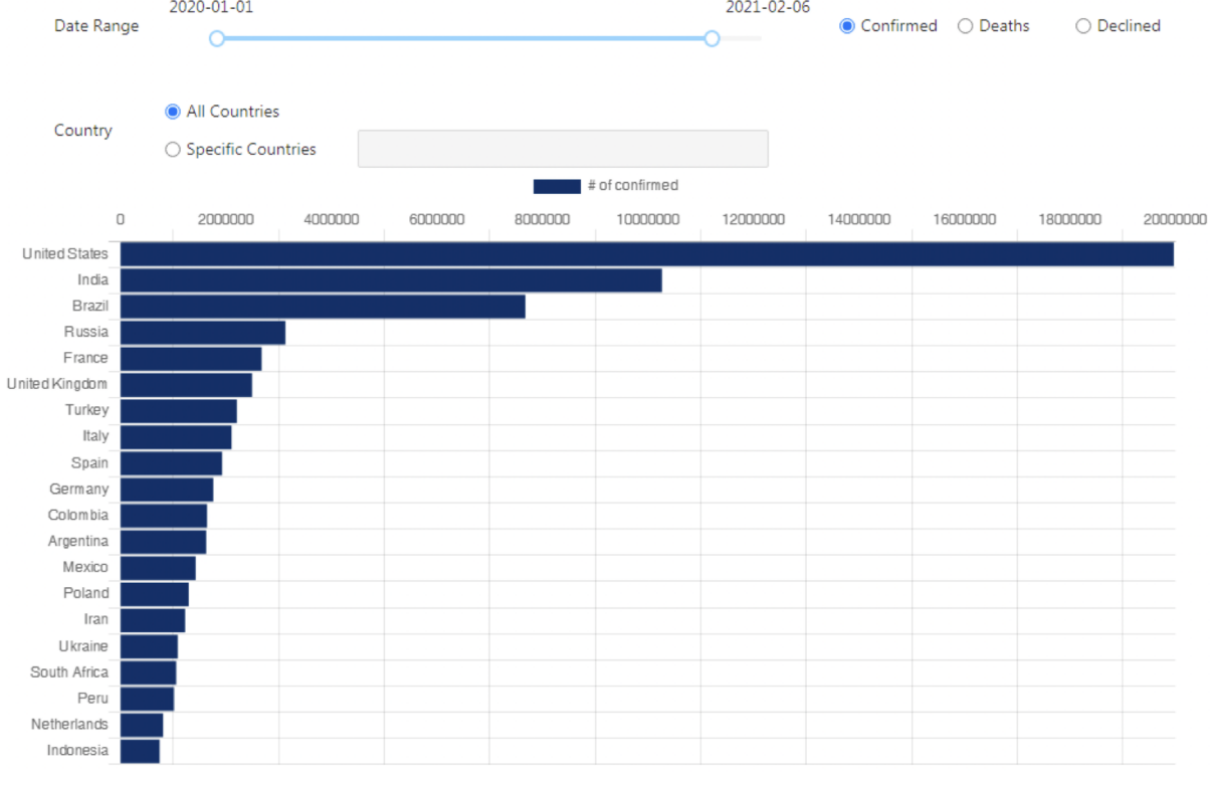
Figure 5. The interface for the ranking of selected countries with customization on the COVID-19 Pandemic AI System (CPAIS)